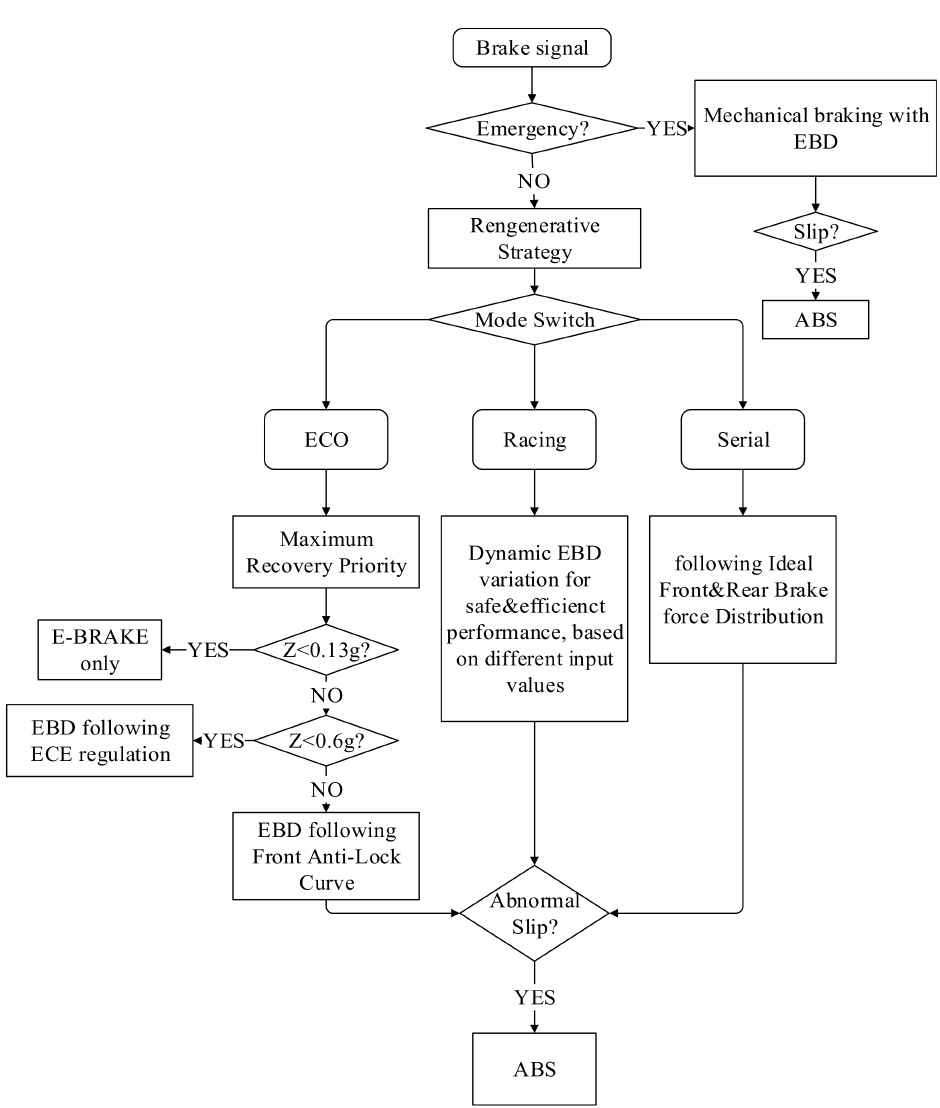
Figure 9. Upper frame of braking strategies for the regenerative braking system (RBS), electronic brakeforce distribution (EBD) and antilock braking system